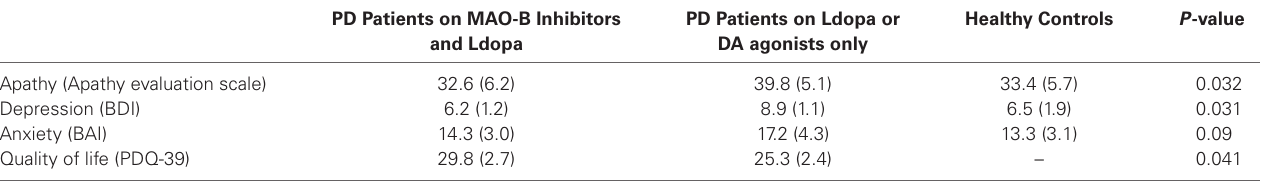
Table 3 | Effects of combined MAO-B Inhibitors and levodopa vs. monotherapy on affective and quality of life measures . PD Patients on MAO-B